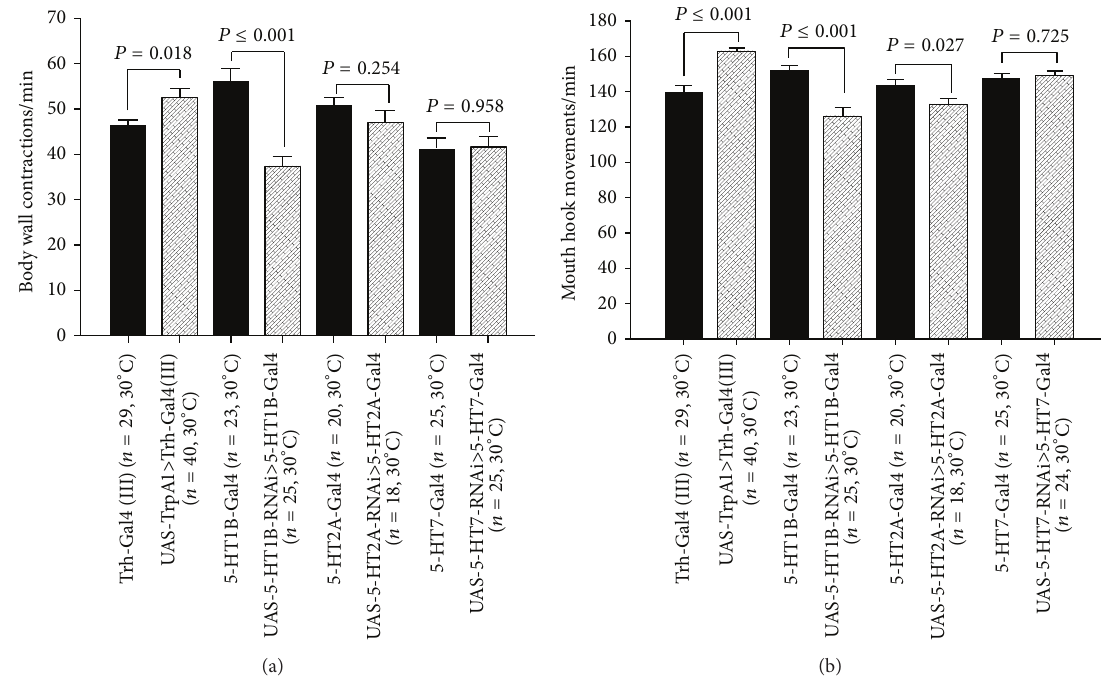
Figure 6: Manipulation of the 5-HTergic system. (a) Activation of serotonergic neurons, by using thermogenetic approach (TrpA1 channels), duringearlystagesofdevelopmentmodulateslocomotionbehaviorinlaterstageofdevelopment.RNAinterference-(RNAi-)directed5-HT1B receptor knockdown during early stage of development significantly reduced the locomotion behavior in third-instar larvae. (b) Activation of serotonergicneuronsincreasedthefeedingbehavior.RNAi-directed5-HT1Band5-HT2Areceptorssignificantlyreducedthefeedingbehavior in third-instar larvae. Student’s 𝑡 -test was performed to carry out comparison between groups. Data presented as mean ±